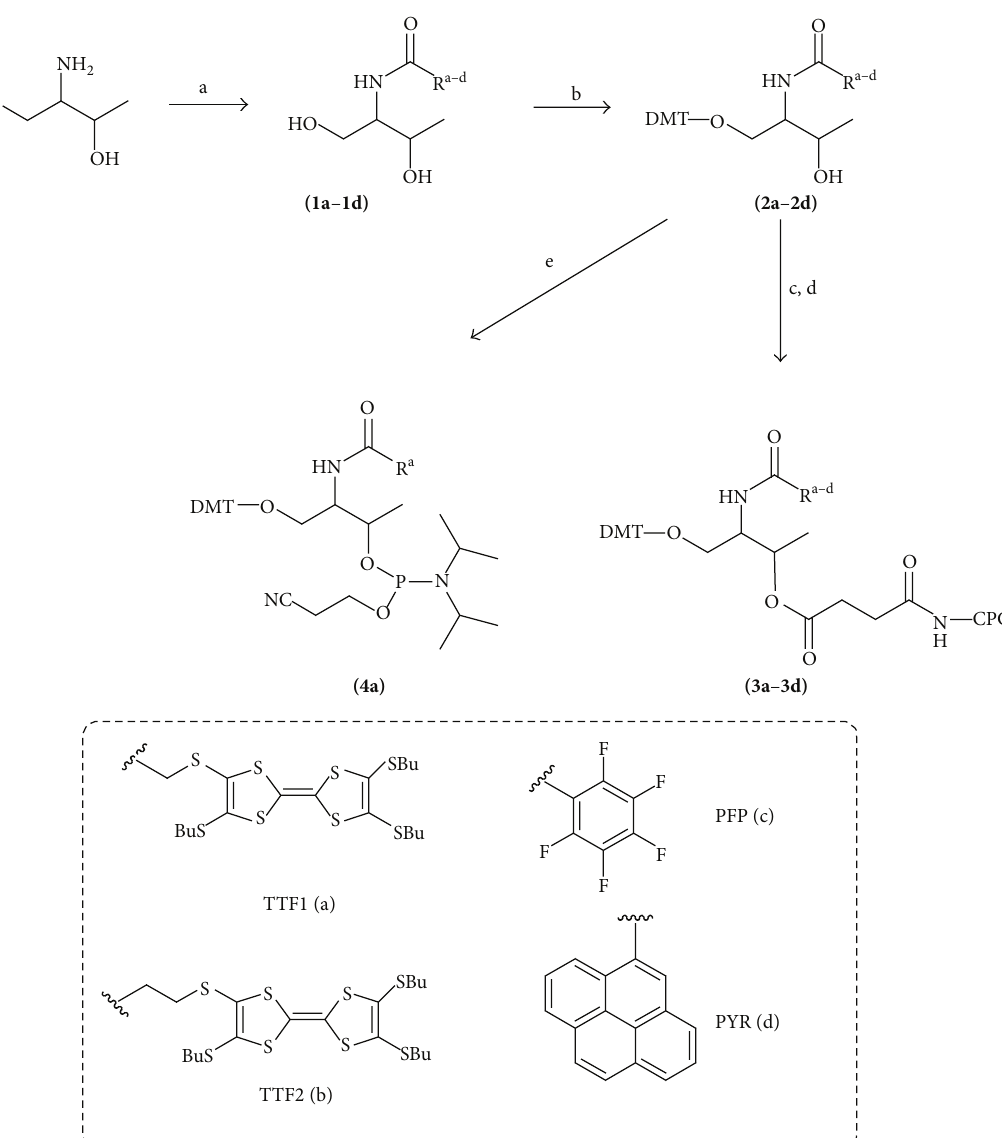
Scheme 1: Preparation of the solids supports and phosphoramidite 4 a needed for the assembly of oligonucleotides. (a) R-COOH,